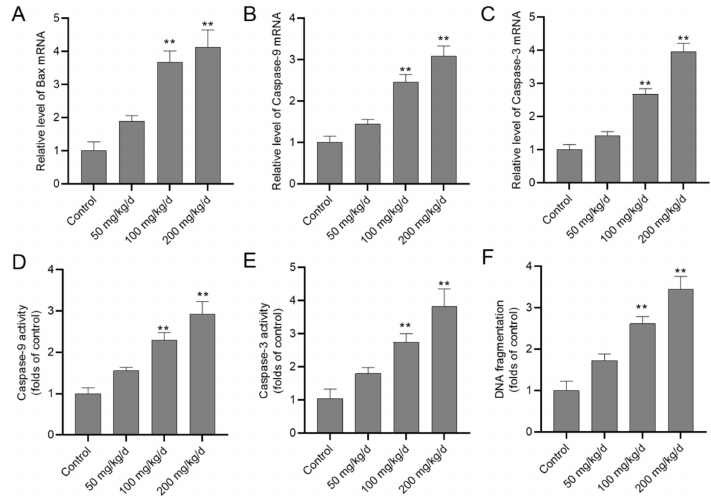
Figure 4. CuSO 4 exposure activates the mitochondrial apoptotic pathway in the kidney tissues of mice. The mice were orally administrated with copper sulfate (CuSO 4 ) at the dose of 50, 100 and 200 mg / kg / day for 28 days, the mRNA expressions of Bax ( A ), caspase-9 ( B ), and -3 ( C ) and the activities of caspase-9 ( D ), and -3 ( E ) in the kidney tissues were determined. The DNA fragmentation in the kidney tissues ( F ) was also examined. Data are presented as mean ± SD ( n = 7). ** p < 0.01, compared to the control